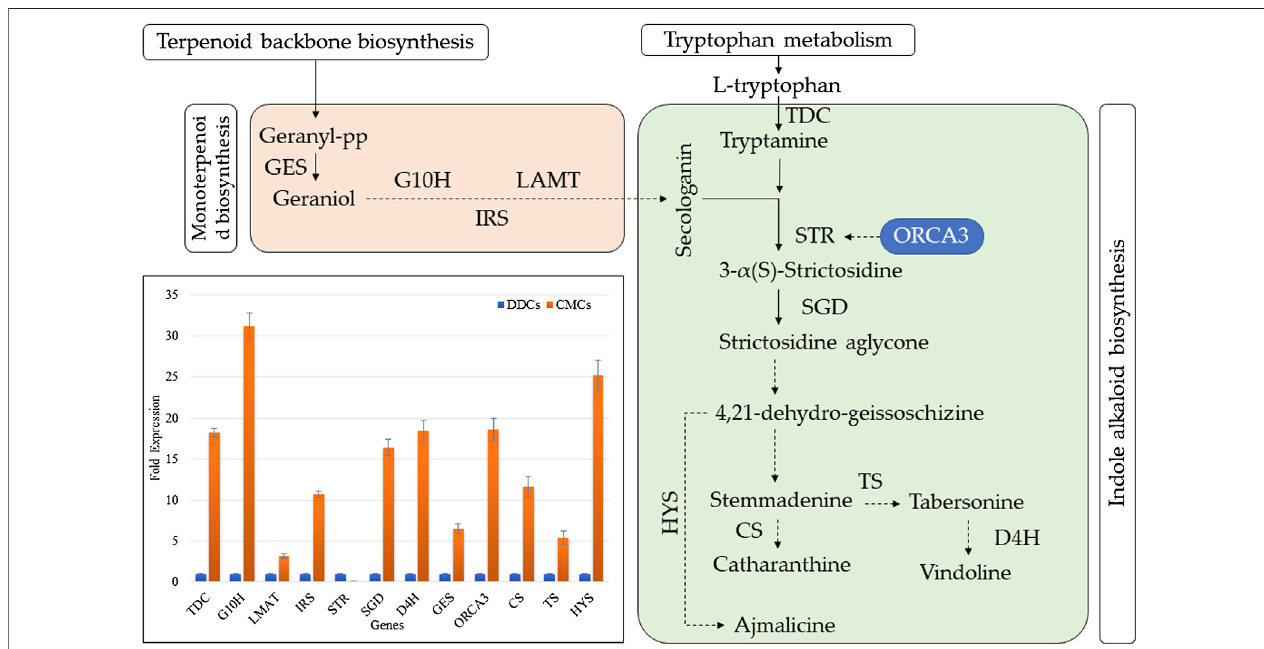
FIGURE 6 | Expression analysis of key genes involved in indole alkaloid biosynthesis in C. roseus CMCs and DDCs. TDC (tryptophan decarboxylase); G10H (geraniol 10-hydroxylase (G10H); IRS (iridoid synthase); LMAT (minovincinine 19-O-acetyltransferase); STR (strictosidine synthase); SGD (strictosidine ß -glucosidase); D4H (desacetoxyvindoline 4-hydroxylase); GES (geraniol synthase); ORCA3 (Octadecanoid-derivative Responsive Catharanthus AP2-domain); HYS (heteroyohimbine synthase); TS (tabersonine synthase); and CS (catharanthine synthase). The dotted arrows indicate indirect link/uncharacterized reaction/multiple reactions. The normalarrowindicates normalreaction(molecularinteraction). ThebargraphshowstheqRT-PCRbasedexpressionoftheselectedgenes.Thefoldexpression ismean of three reactions. The error bars represent standard deviation.